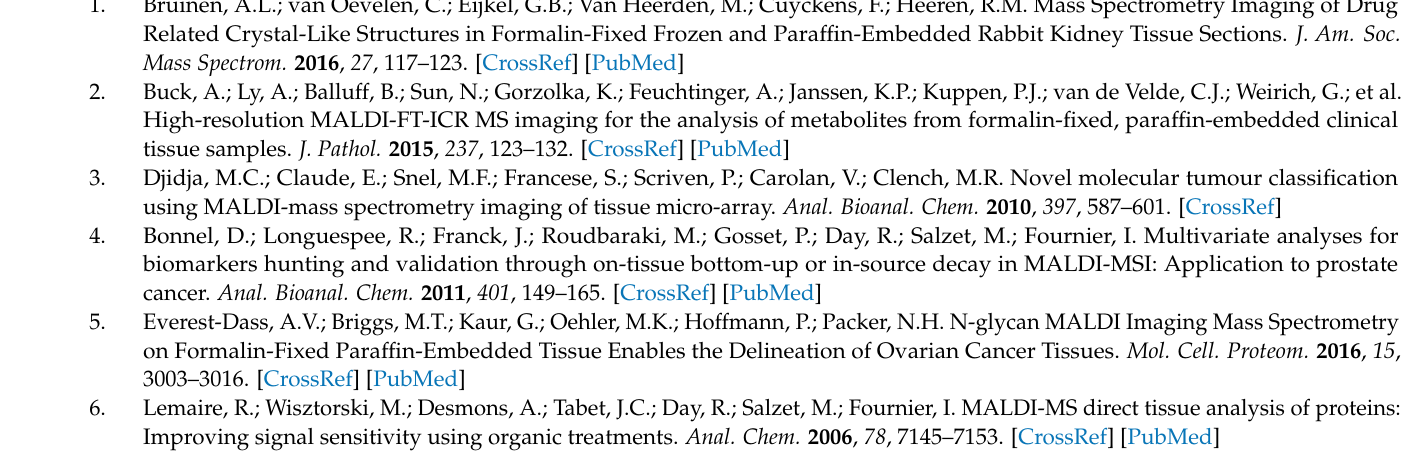
Table S2: Statistical information for annotated heatmap features; Figure S1: MS/MS spectra of heatmap lipids; Figure S2: Pixel-wise PCA performed on sections from all tissue sections; Figure S3: Progression of the fixation front in rat over time; Figure S4: Distribution of PI(38:4) in fresh- frozen, formalin-fixed and formalin-fixed, paraffin embedded rat liver; Figure S5: H&E stained FFPE sections prepared from tissue collected and stored in 10% formalin or snap-frozen upon collection and subsequently fixed in 10%